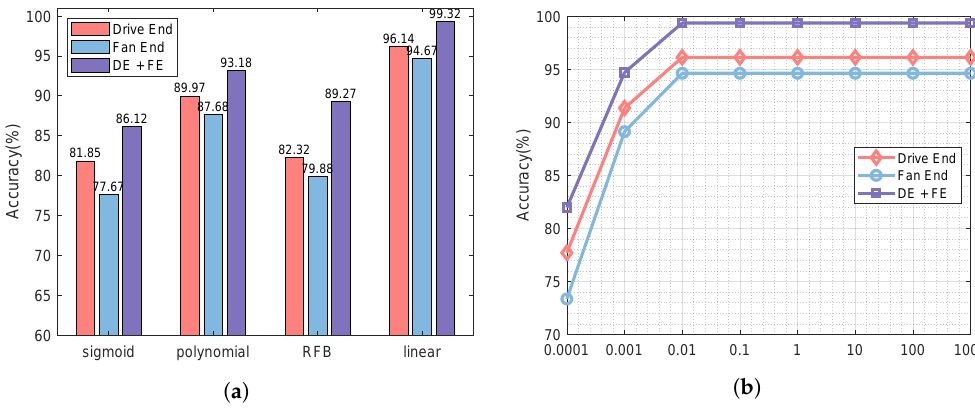
fusion of low-quality samples is helpful to improve the accuracy of fault prediction.